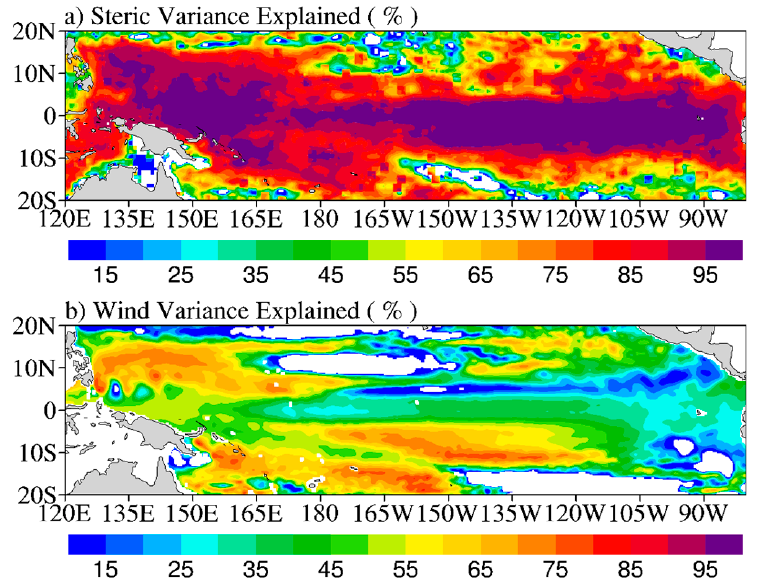
Figure 6. The interannual sea level explained variances of ( a ) the steric effects and ( b ) the dynamic process. The interannual sea level fluctuation signals of TPO are affected by the sea surface wind forcing. The dominant contribution to interannual sea level variations in western TPO is the wind-induced first baroclinic Rossby waves [7,24,32,36]. Therefore, exploring the relative effects of wind forcing in the TPO and the wind forcing in other regions on the interannual sea level variations is necessary. The variances explained by the wind forcing in different regions from the sensitivity control experiments (Figure 7) reveal that the real monthly wind forcing contributed to the interannual sea level variations. These are larger in the northwest, south, and southwest (>65%), only reaching 65% in the northeast. However, its contribution is minor and even negative in other regions. When the TPO is modeled with the real monthly wind field, and other regions are the climatic wind fields (Figure 7b), the contribution of local wind forcing to the interannual sea level variations in the TPO is almost the same as the real wind forcing. The variances are also the same, indicating that the local wind field in the TPO plays a leading role in influencing the interannual sea level variations. However, when the subtropical north Pacific Ocean is modeled with the real monthly wind field and TPO is the climatic wind field (Figure 7c), the subtropical north Pacific Ocean wind field explains less than 15% of the variances of the interannual sea level variations. This indicates that the subtropical north Pacific wind forcing barely contributes to this region. Therefore, the local wind forcing in the TPO is the leading role of the interannual sea level